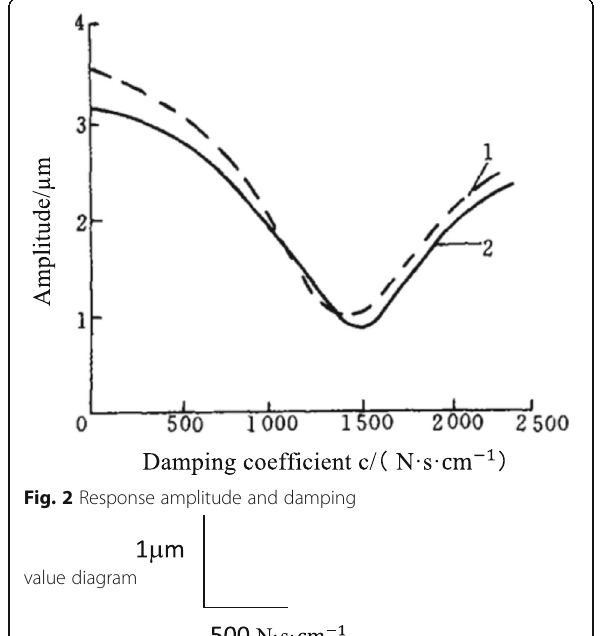
Fig. 2 Response amplitude and damping